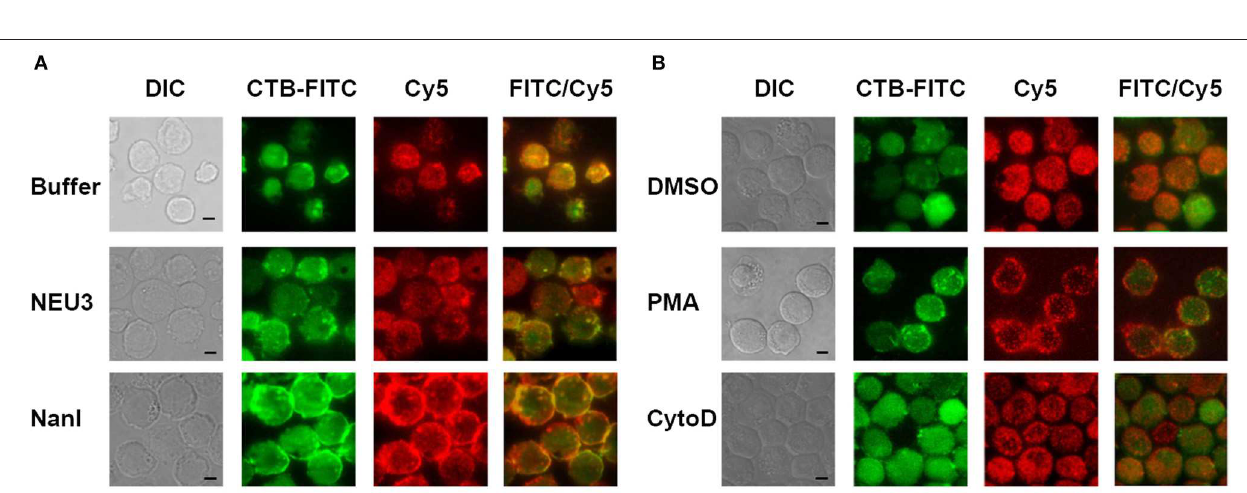
Frontiers in Chemistry |